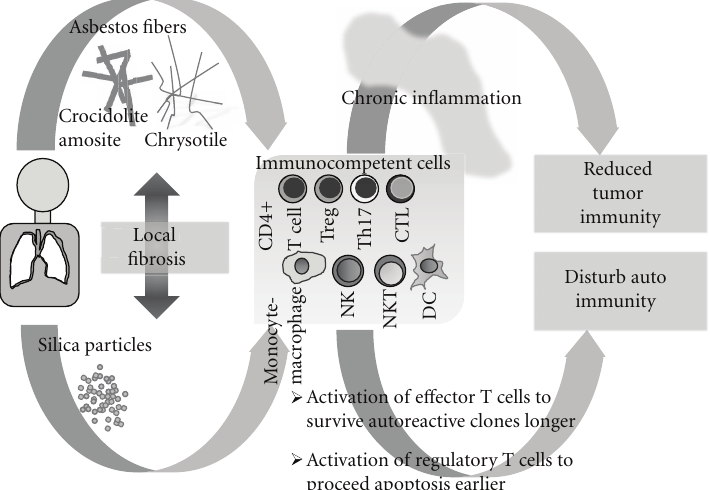
Figure 4: Schematic model presenting the di ff erences of immunological e ff ects of silica and asbestos based on our findings. Silica may disturb the autoimmunity, and asbestos may cause reduction of tumor immunity via forming chronic